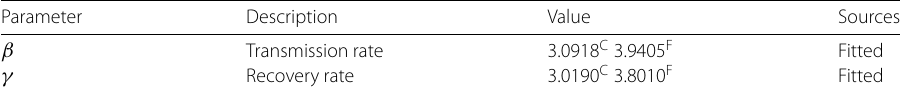
Table 1 Best fitted parameters employed in model (5) for its classical ν = 1 and fractional ν = 8.561591e-01